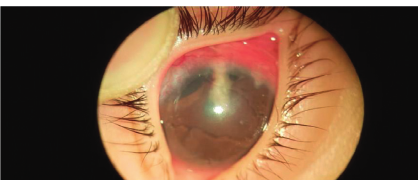
Figure 2: A dense fibrous sleeve formed around the tube, similar to the case shown in Figure 1.